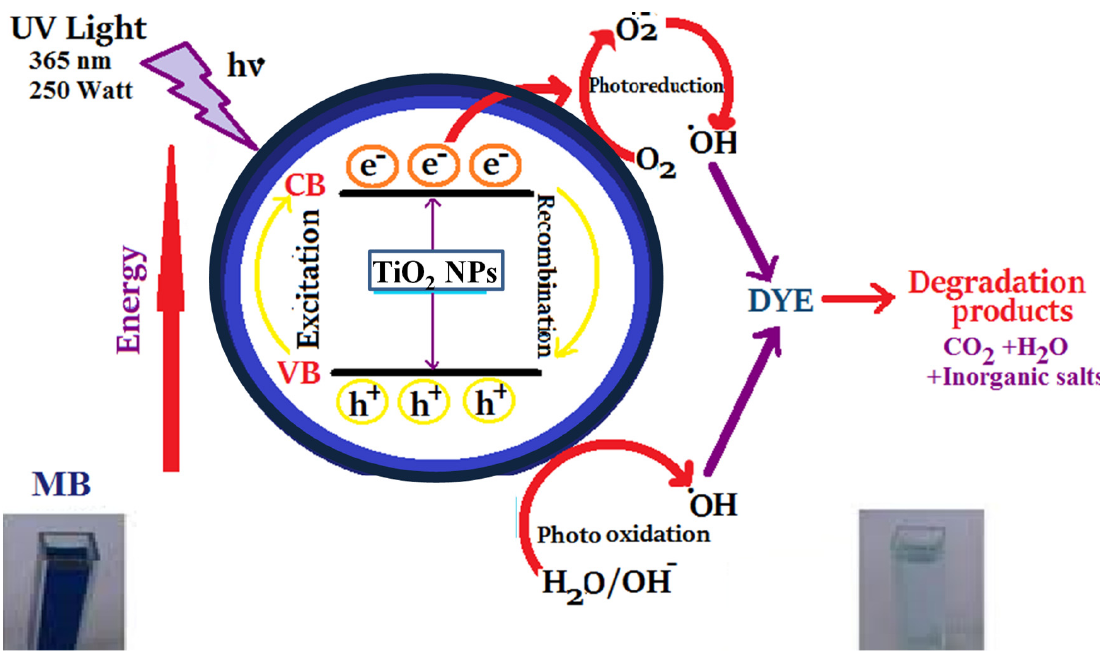
Figure 10. Mechanism of MB degradation.